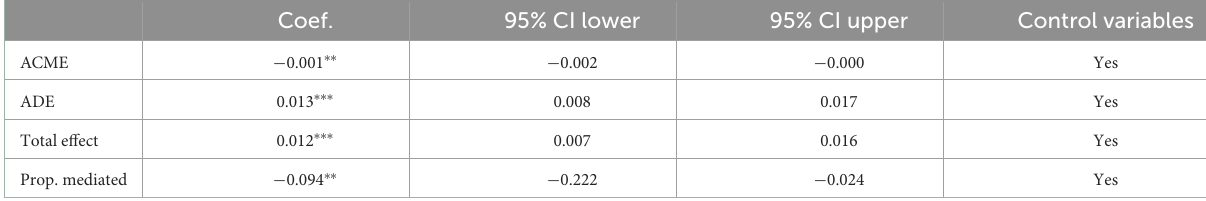
TABLE 7 Mediating effect analysis by